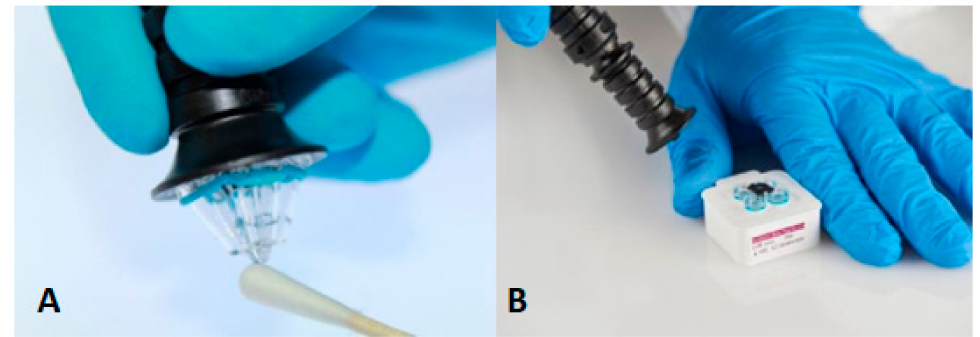
Figure 3. ( A ) The sample collector of the ParaDNA system, ( B ) The nibs of the sample collector inserted into the reaction plate [41]. Reprinted from Forensic Science International: Genetics Supple- ment Series, 6, Copyright (2017), with permission from